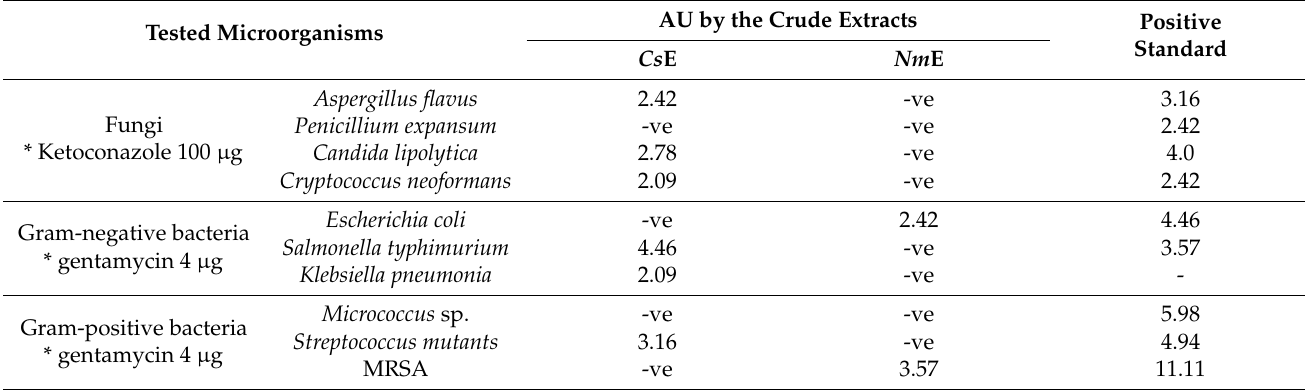
Table 3. Antimicrobial activity of Cs E and Nm